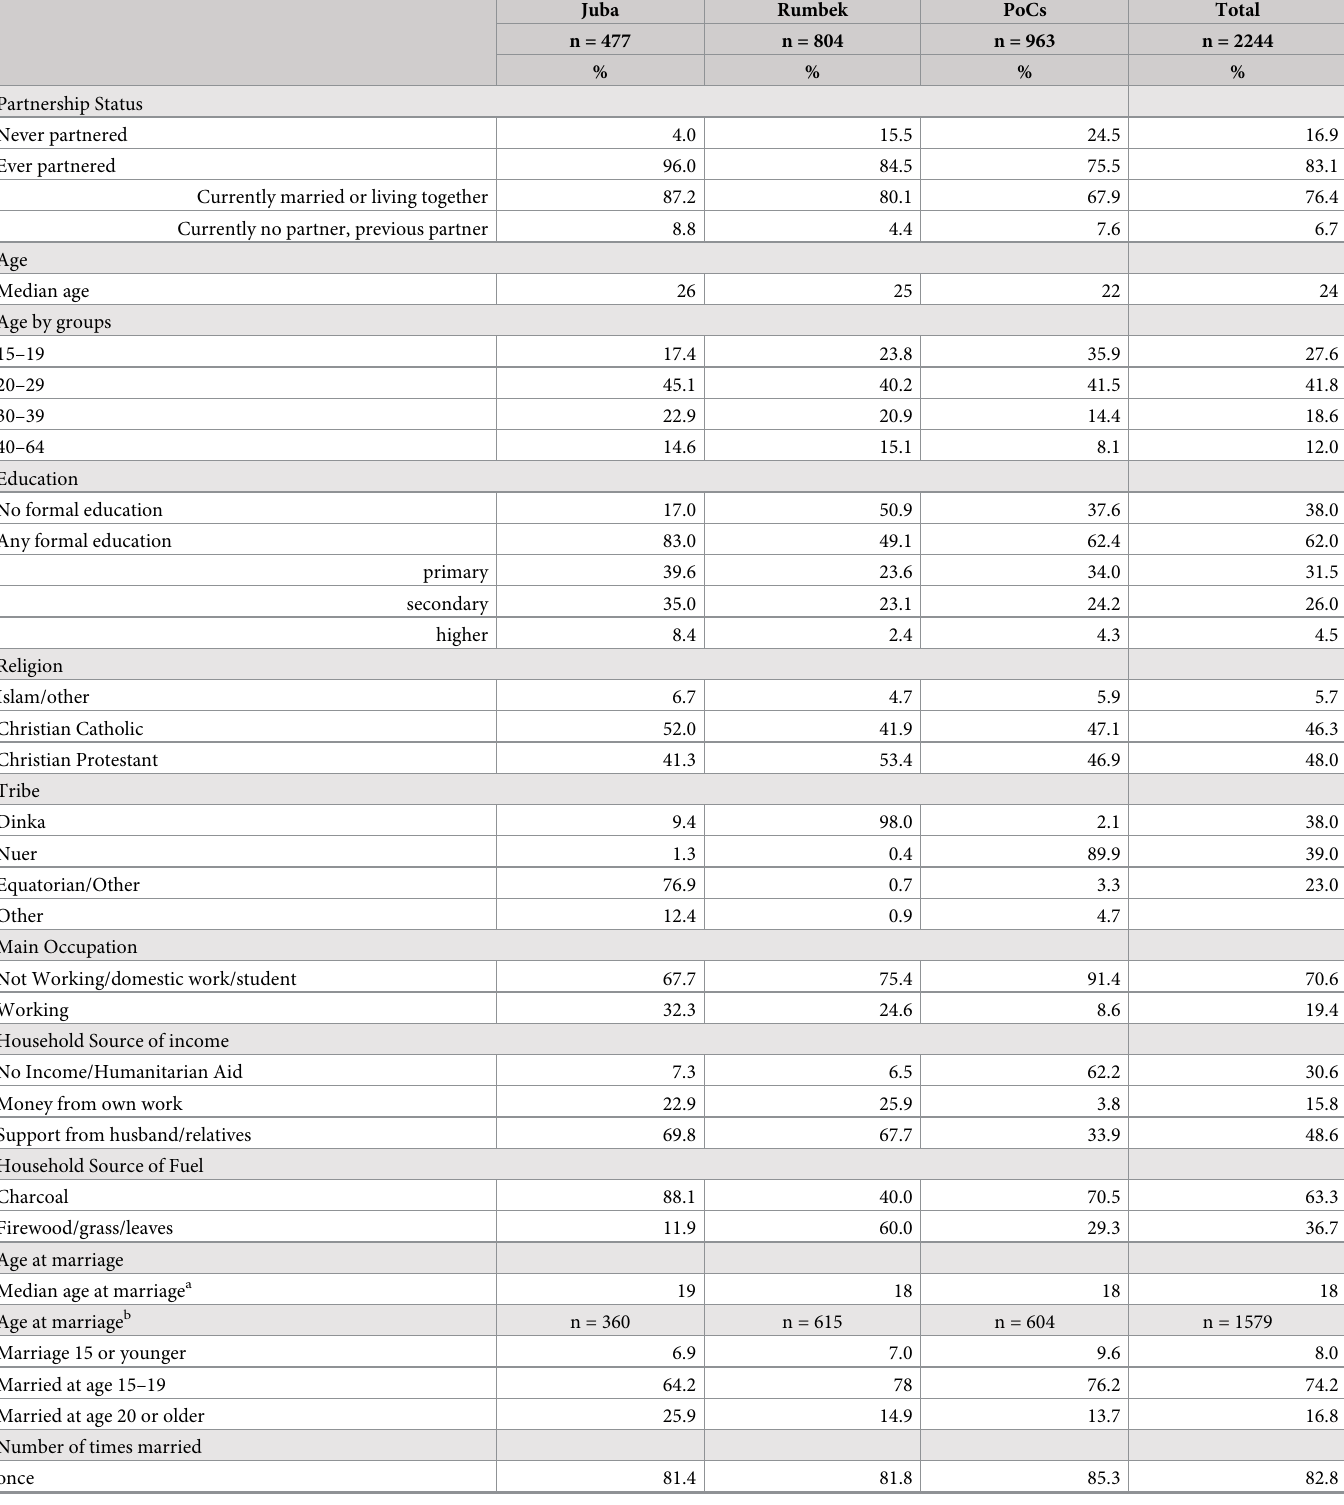
Table 1. Demographic and social characteristics of